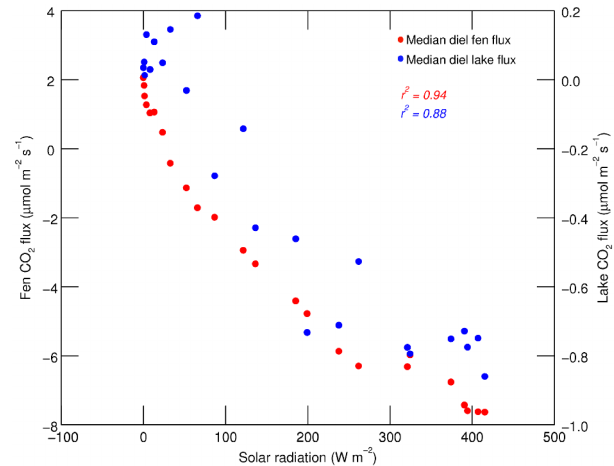
Figure 9. Diel median of the net CO 2 exchange at the fen (red) and at the lake (blue) vs. diel median solar radiation, between June and August. Each dot is the hourly median flux of the combined three ice-free seasons. Note that the two y axes have different